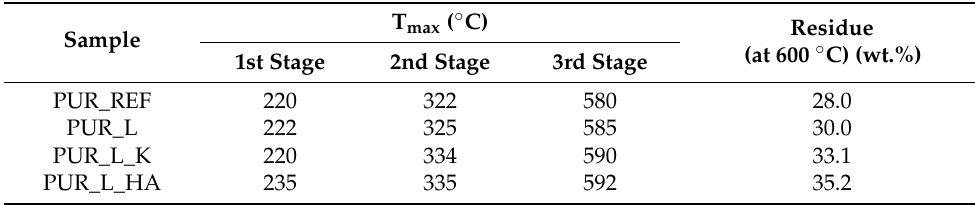
Figure 7. Thermogravimetric (TGA) and derivative thermogravimetry (DTG) results obtained for ( a , b ) lavender fillers, and ( c , d ) PUR composites. Table 3. The results of thermal stability of PUR